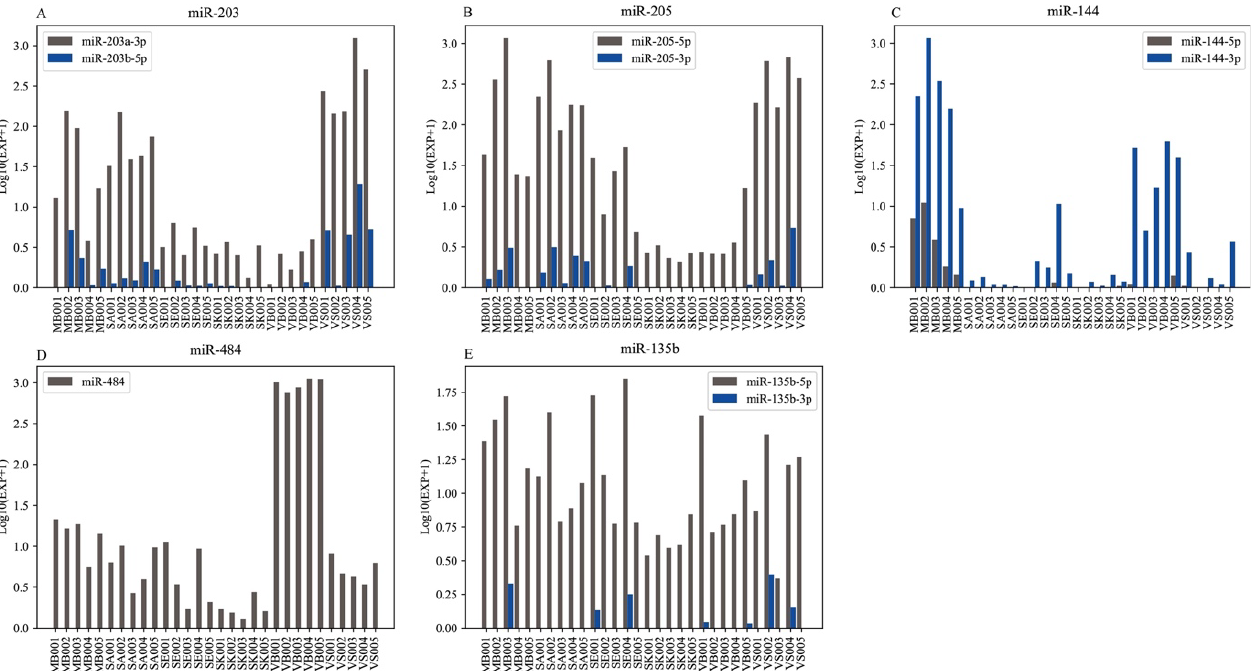
Figure 6. A comparison of the expression level of five miRNAs in all samples. ( A ) miR-203; ( B ) miR-205; ( C ) miR-144; ( D ) miR-484; ( E ) miR-135b.